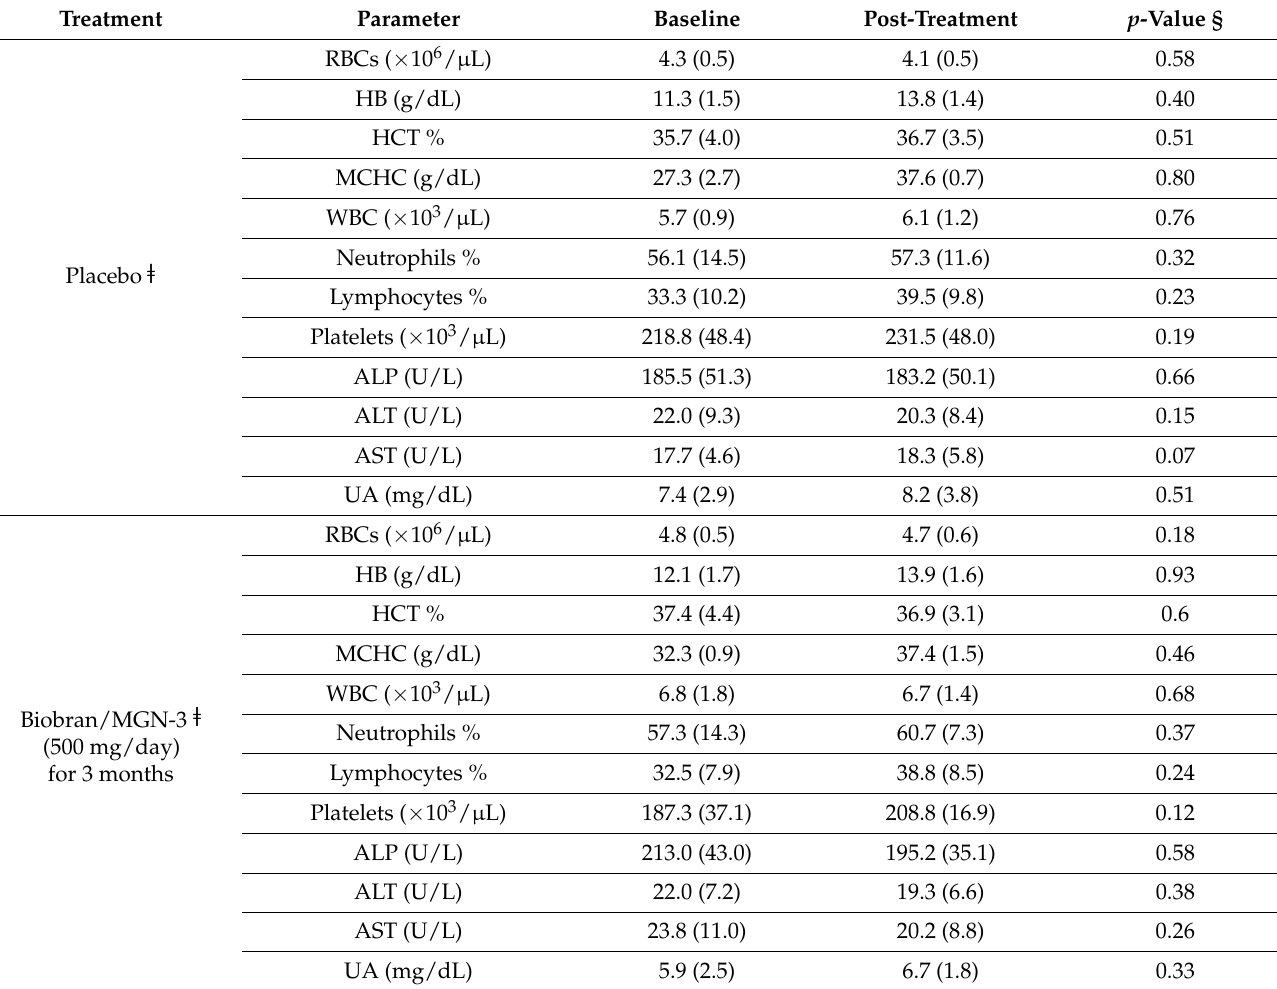
§ p -values represent comparison between post-treatment and baseline values and were determined using paired t-test because all data were normally distributed. All comparisons yielded non-significant differences between the post-treatment and the basal levels. ǂ Comparison between placebo and Biobran/MGN-3 groups yielded non-significant differences with regards to all variables. p ≤ 0.05 was considered statistically significant. RBC, red blood cell; Hb, hemoglobin; HCT, hematocrit; MCV, mean corpuscular volume; MCH, mean corpuscular hemoglobin; WBC, white blood cell; ALT, alanine aminotransferase; AST, aspartate aminotransferase; UA, uric